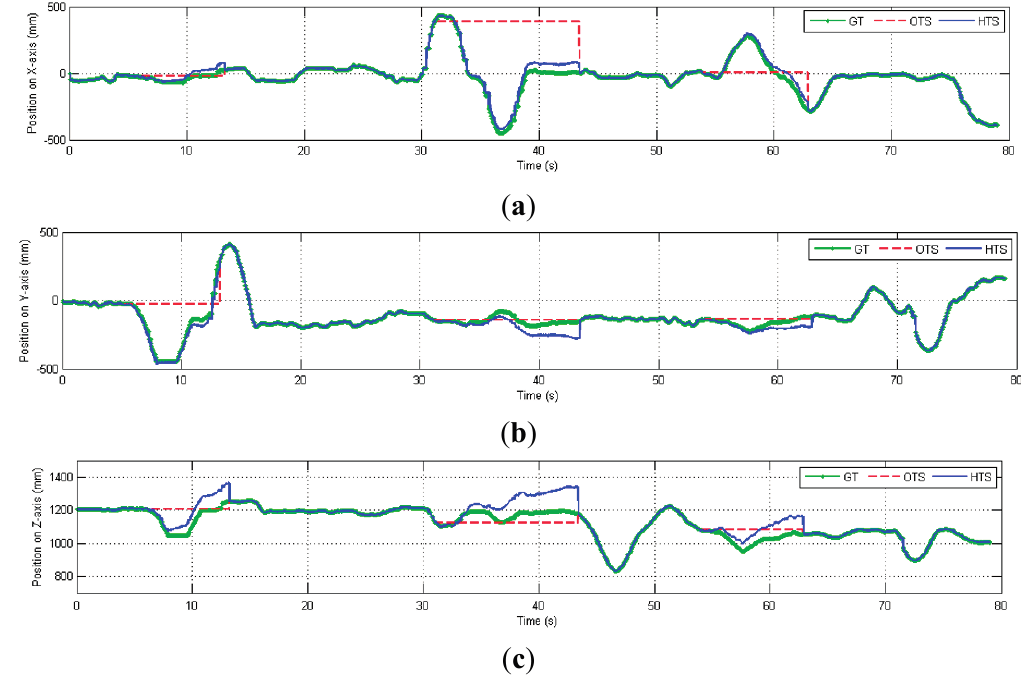
Figure 13. Position (mm) in three-axes versus time, including cases of full OTS occlusion (dashed red lines). ( a ) Position on X-axis; ( b ) Position on Y-axis; ( c ) Position on